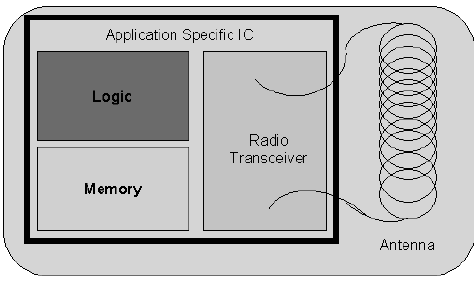
Fig 1. Structure of contactless smart card